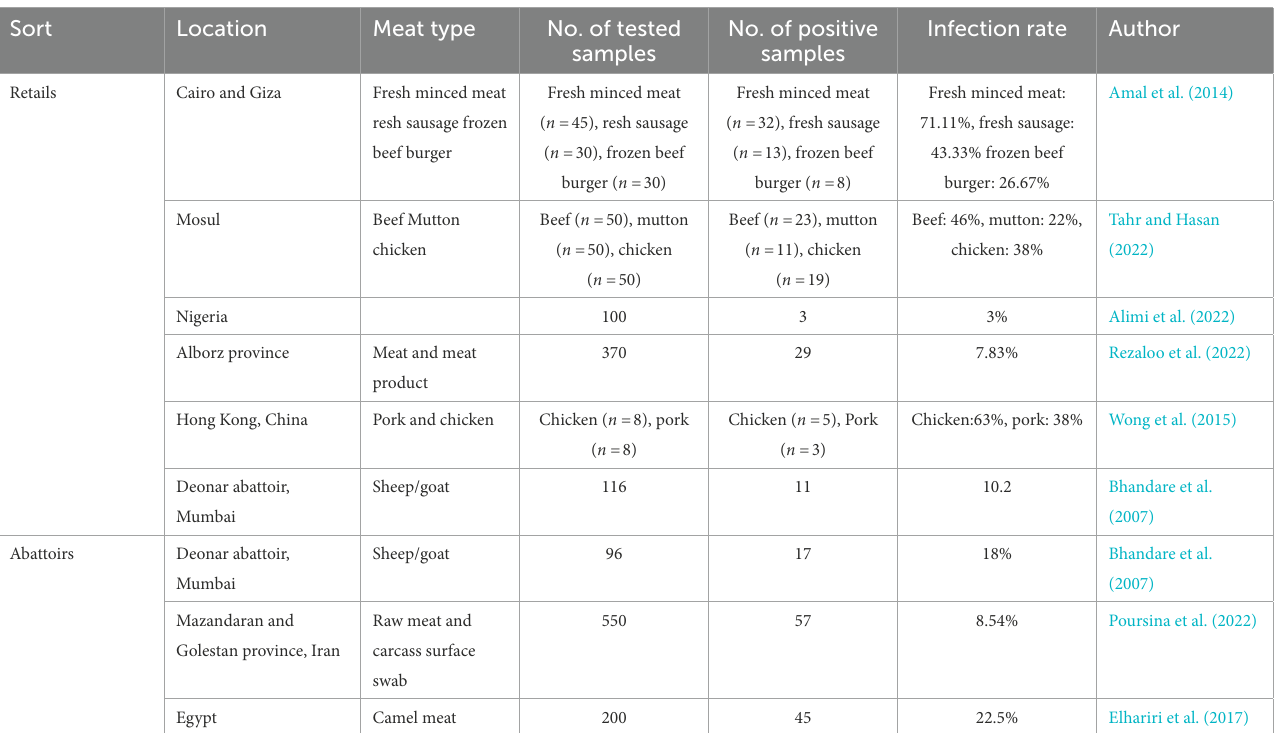
TABLE 2 Prevalence of P. aeruginosa in different types of meat. Sort Location Meat